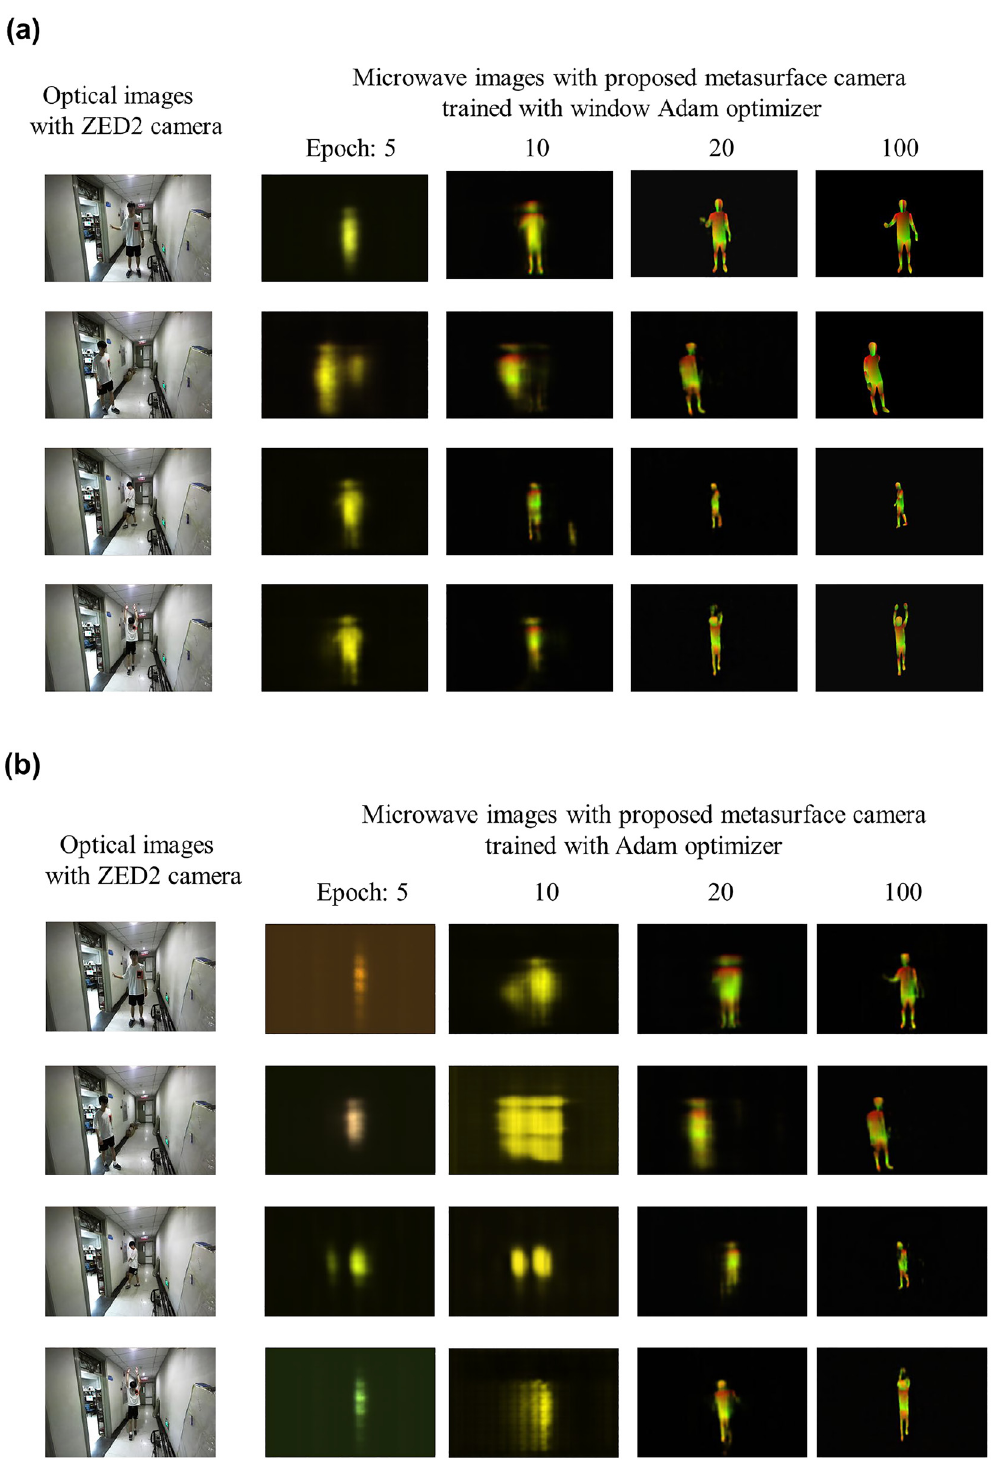
Figure 7: Performance evaluation of our intelligent EM camera for sensing human behaviors in through-wall environment. (a)and(b)correspondtoselectedIUVimagesoftestpersonwithfourdifferentgestureswithvaryingtrainingepochs,wherethewindow-Adam and Adam are used, respectively. (c) Comparison of convergence behaviors of MSEs over 1000 1.2 s-length microwave videos as function of training epochs when the window-Adam (orange line) and Adam (blue line) optimizers are used, respectively. (d) Figures in Left and Right are forthenormalizedhistogramsofPSNRSover10001.2s-lengthmicrowavevideosrecordedbyusingourEMcameratrainedwiththeAdamand window Adam optimizer,